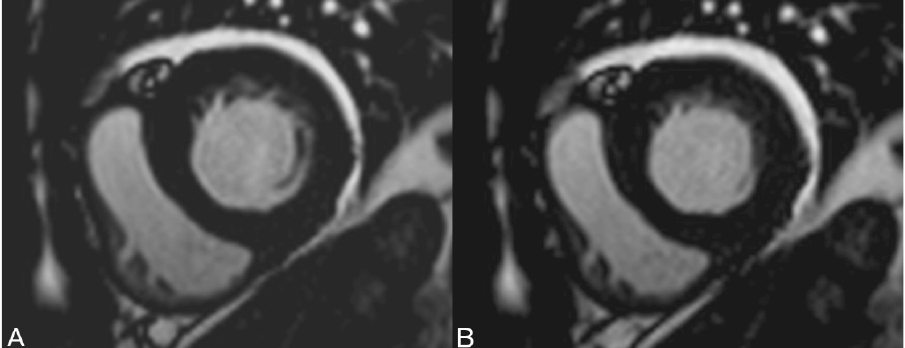
Figure 5. Good visual differentiation of the papillary muscle and the endocardium in the presystolic phase ( A ) and lack of border between papillary muscle and endocardium in systole ( B ).